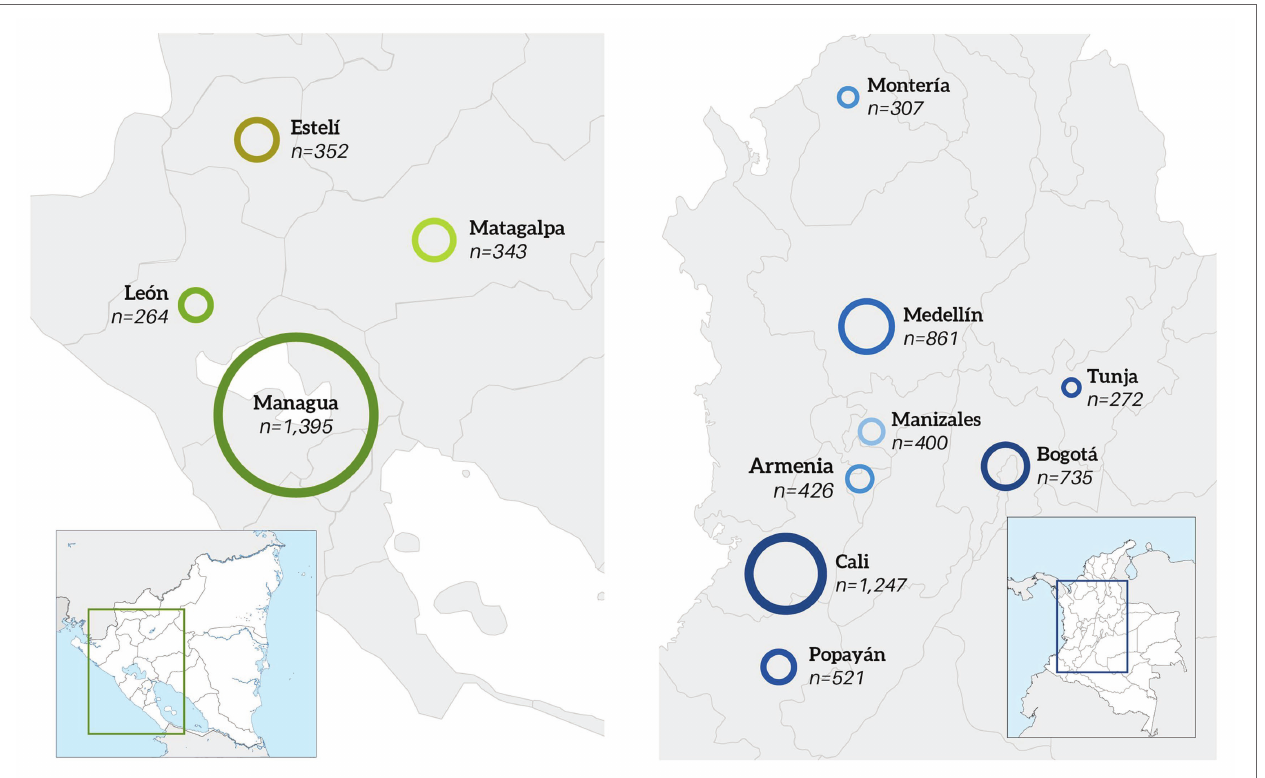
FIGURE 1 | Geographical distribution of the study population for Nicaragua (left) and Colombia